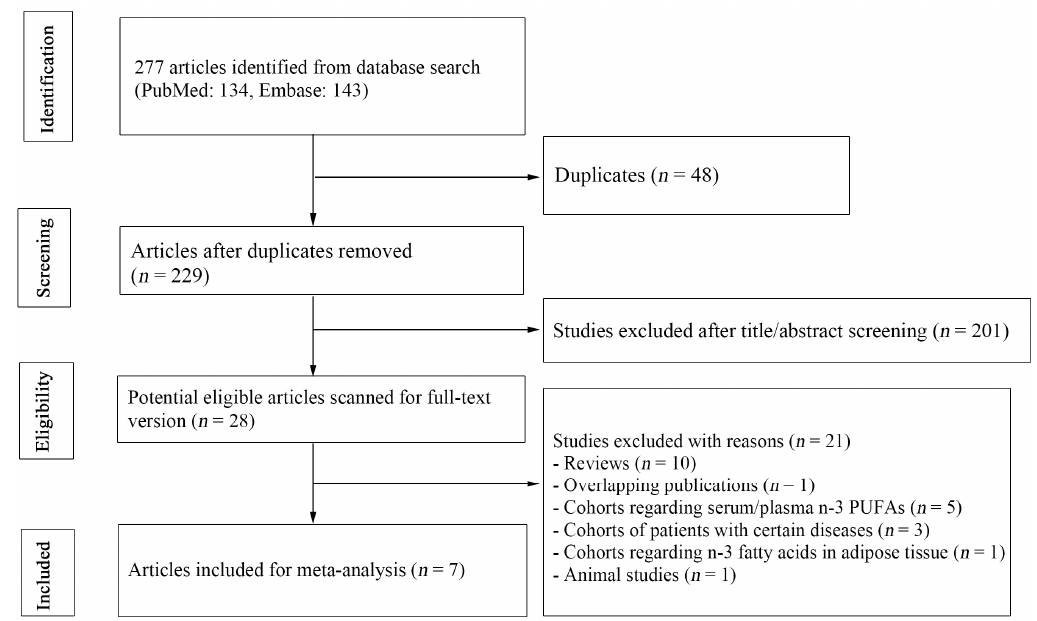
Figure 1. Literature search and study selection.